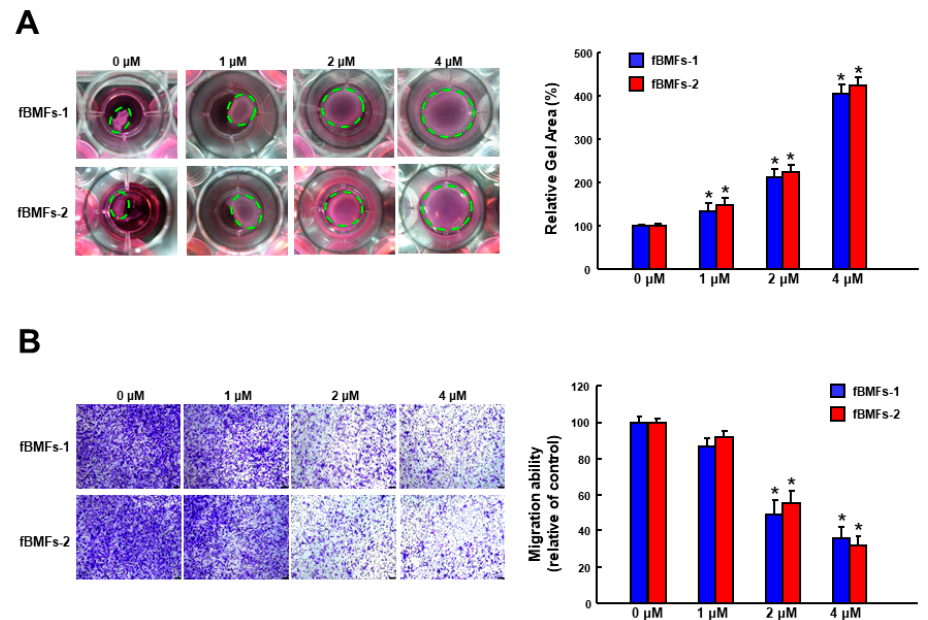
Figure 2. α -mangostin inhibits the myofibroblast activities of fBMFs. ( A ) The contractile capacity of fBMFs was determined by collagen gel contraction assay (three replicates for each concentration). Images of gels were captured, and gel areas (dotted circles) were calculated by ImageJ software. ( B ) fBMFs were treated with the indicated concentration of α -mangostin followed by transwell migration assay. The experiments were repeated for three times and data from a representative experiment were presented. Results are means ± SD. ∗ p < 0.05 compared to control.